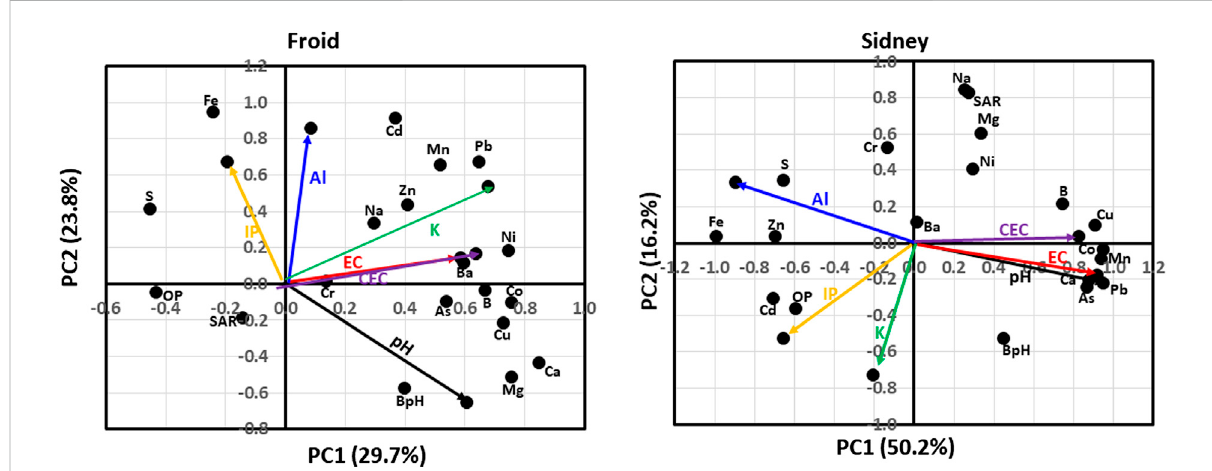
FIGURE 1 Principal component analysis for associations among soil chemical properties at Froid and Sidney, Montana, United States. At Froid, soil chemical propertiesexplained 29.7%ofthetotalvariation inthe fi rstprincipalcomponent(PC1) and23.8% inthesecondprincipalcomponent(PC2). At Sidney, chemical properties explained 50.2% of total variation in PC1 and 16.2% in PC2. BpH denotes buffer pH; EC, electrical conductivity; CEC, cation exchange capacity; IP, inorganic P concentration; OP, organic P concentration; and SAR, Na-absorption ratio.